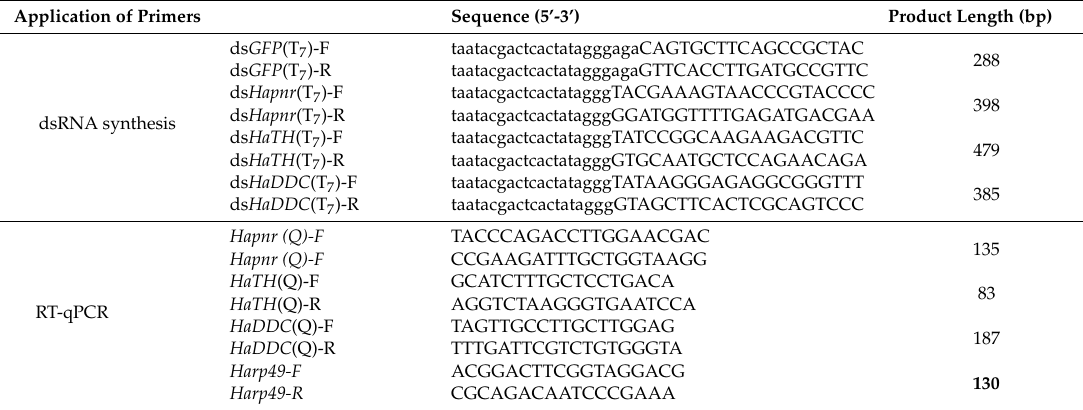
Table 1. Primers used to synthesize dsRNA and analyze transcript